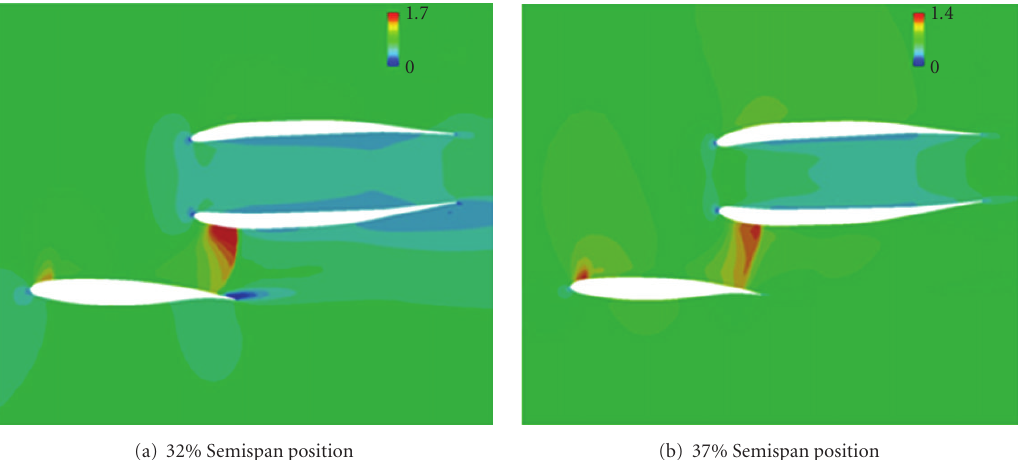
Figure 14: Cp distribution of original Geometry.